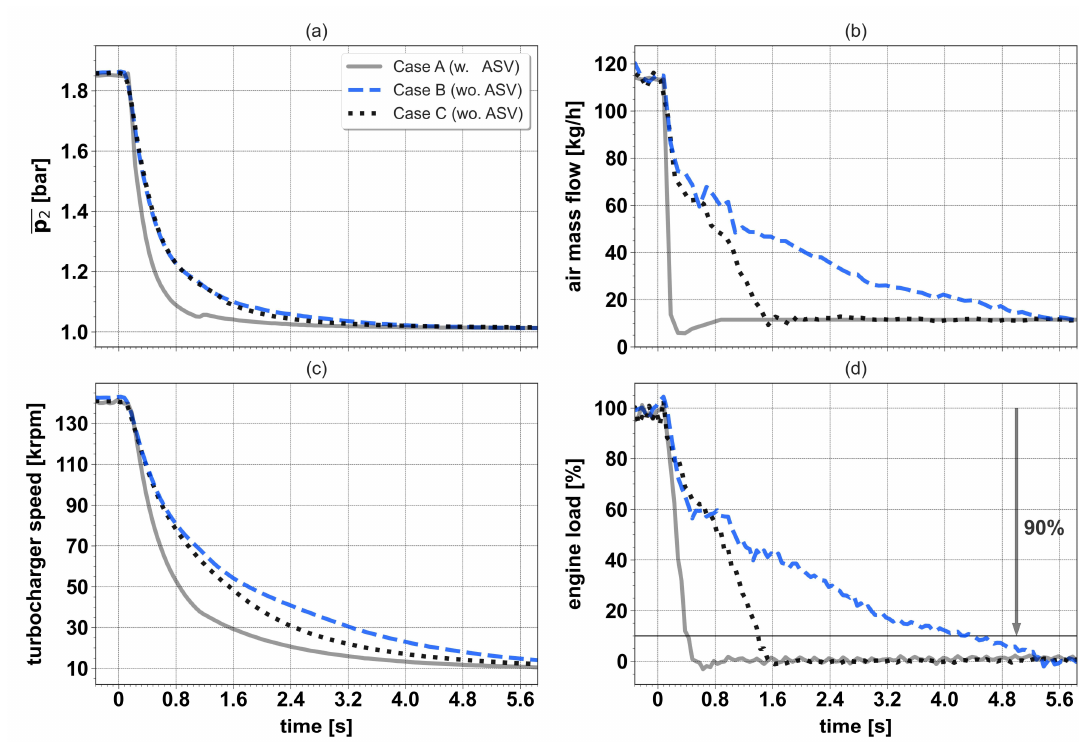
Figure 6. Time evolution of compressor outlet pressure ( a ), air mass flow at filter outlet ( b ), tur- bocharger speed ( c ), and engine load ( d ) for Cases A, B, and